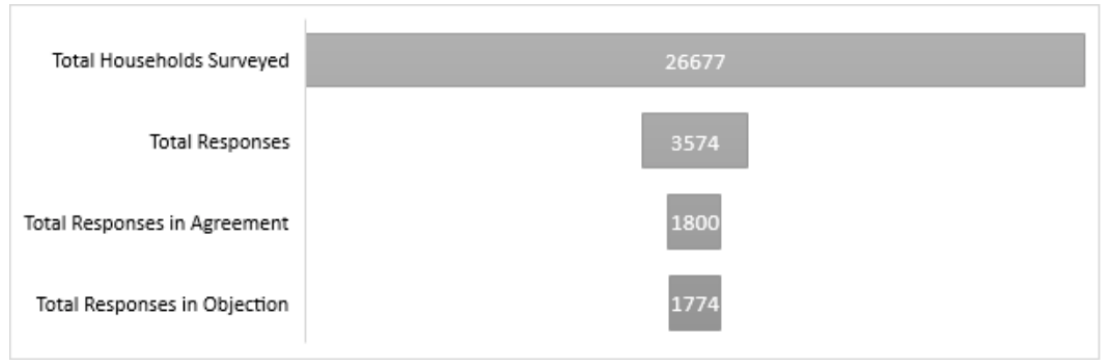
ffi eld City Council